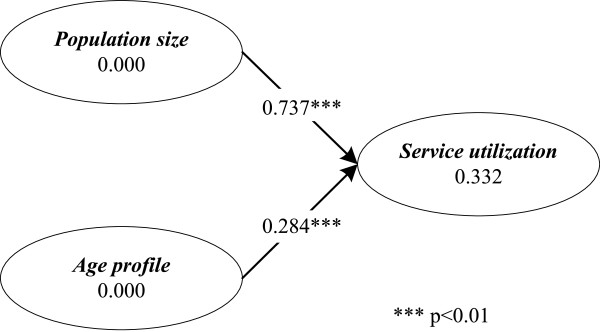
SEM test results — the effects ofpopulation size andage profile onservice utilization. The results of PLS-based SEM testing show that population size and age profile are both positively related to service utilization.